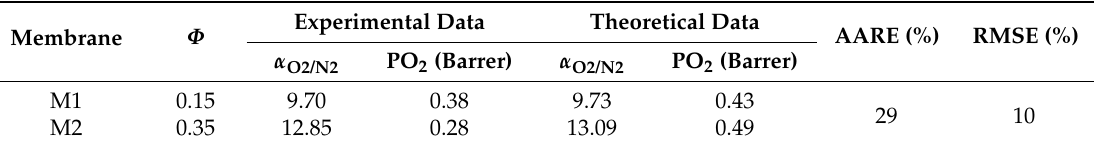
Experimental [39] and theoretical MOT-predicted data for the zeolite 4A-Ultem mixed-matrix